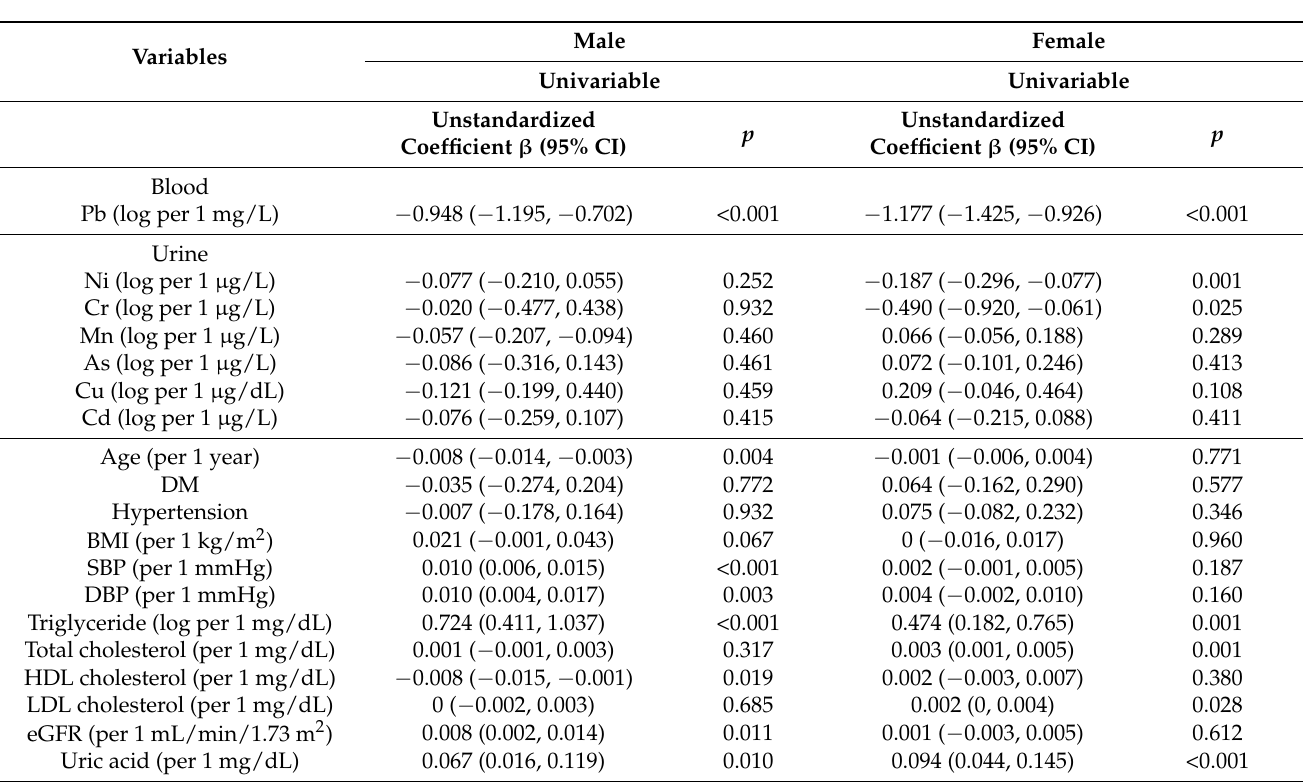
Table 6. Association of heavy metals and variables with MCHC using univariable linear regression analysis by